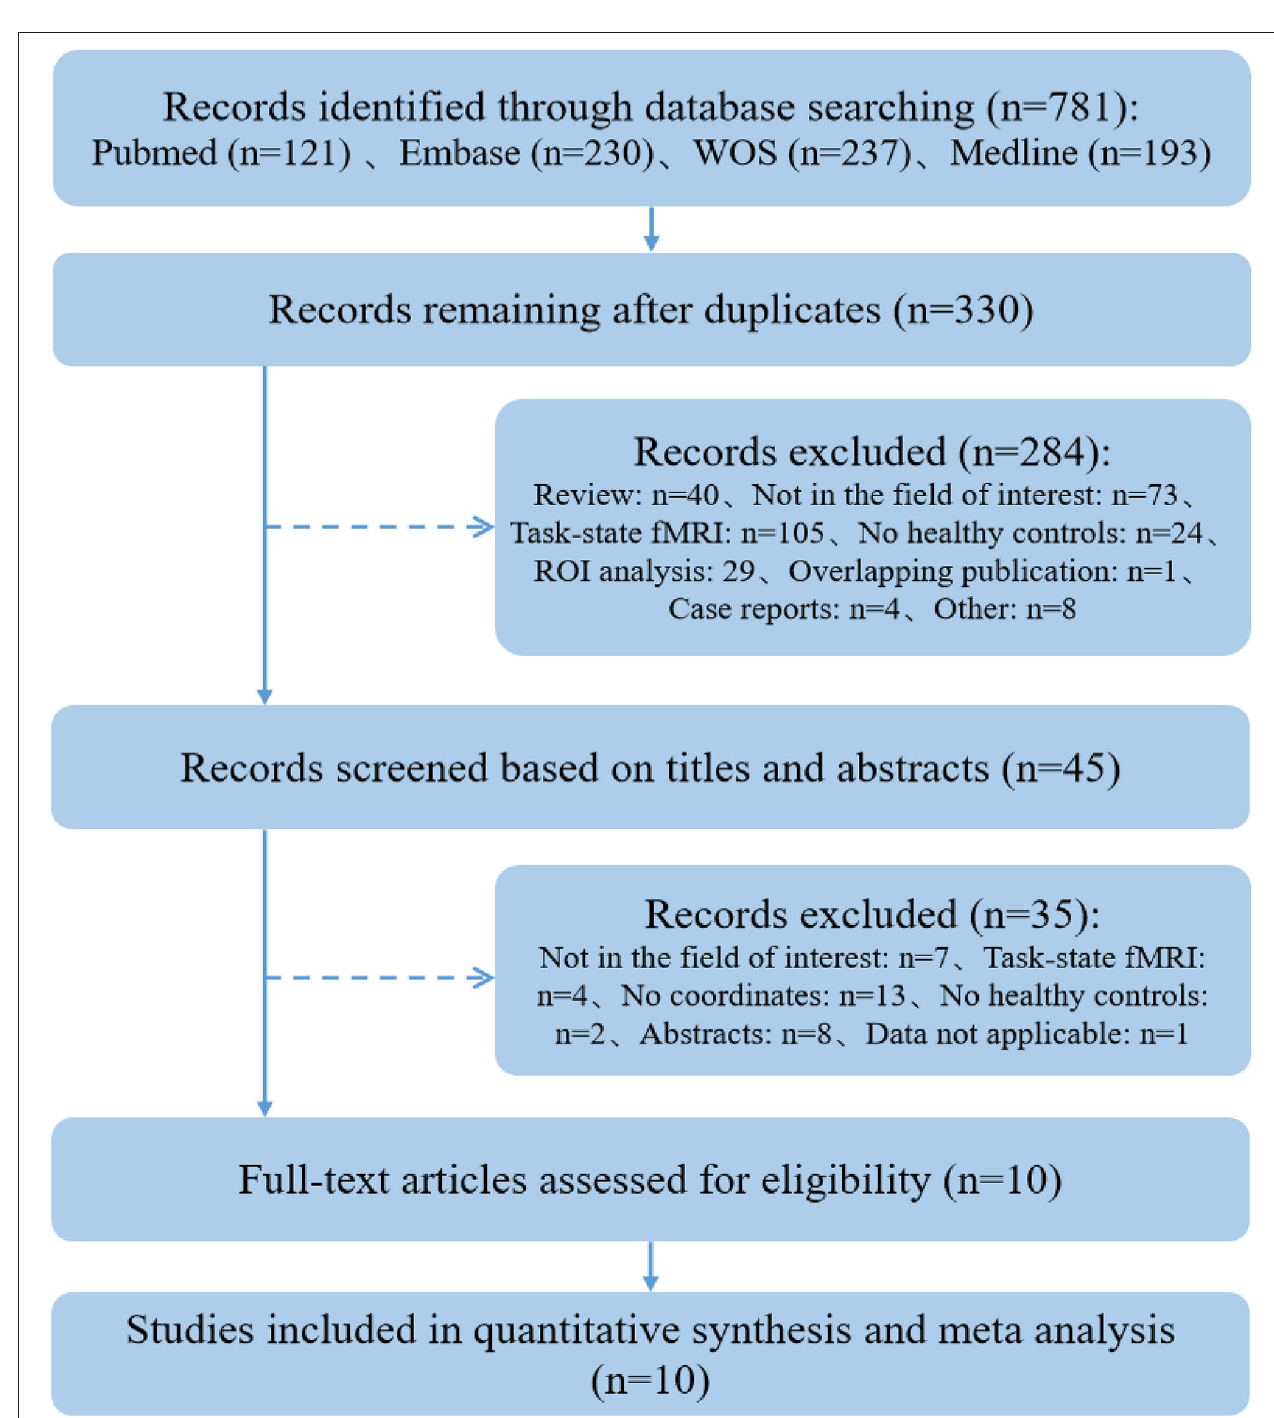
FIGURE 1 | A flow chart of the study selection process.